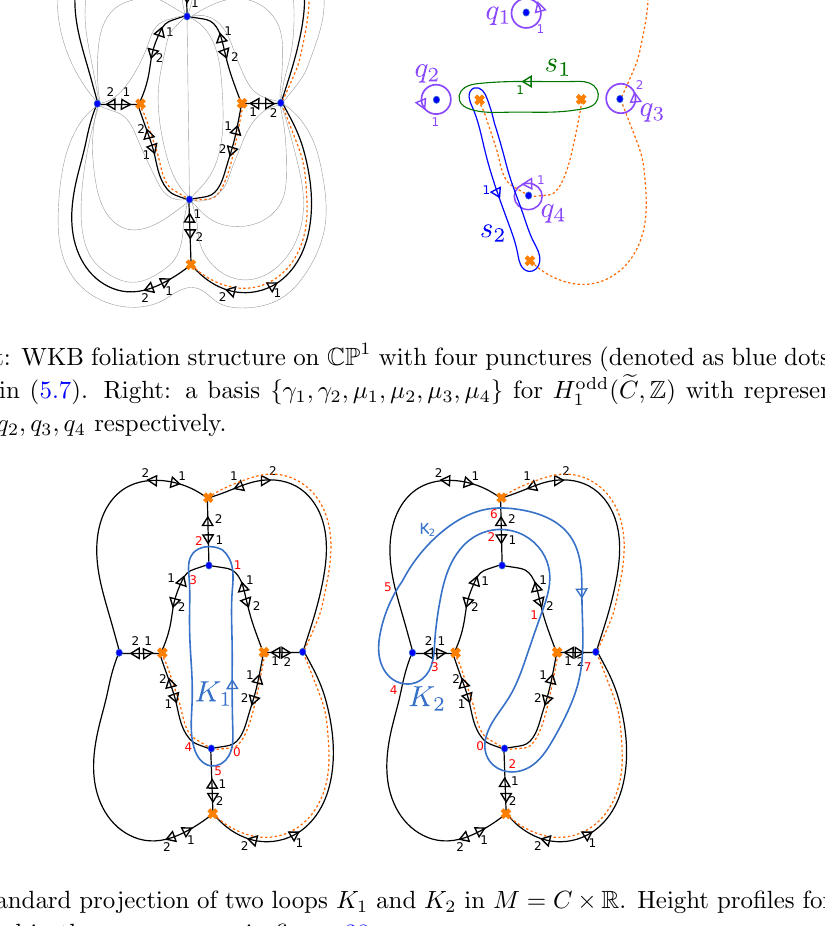
Figure 42 . Standard projection of two loops K 1 and K 2 in M = C (cid:2) R . Height pro(cid:12)les for these loops are speci(cid:12)ed in the same way as in (cid:12)gure